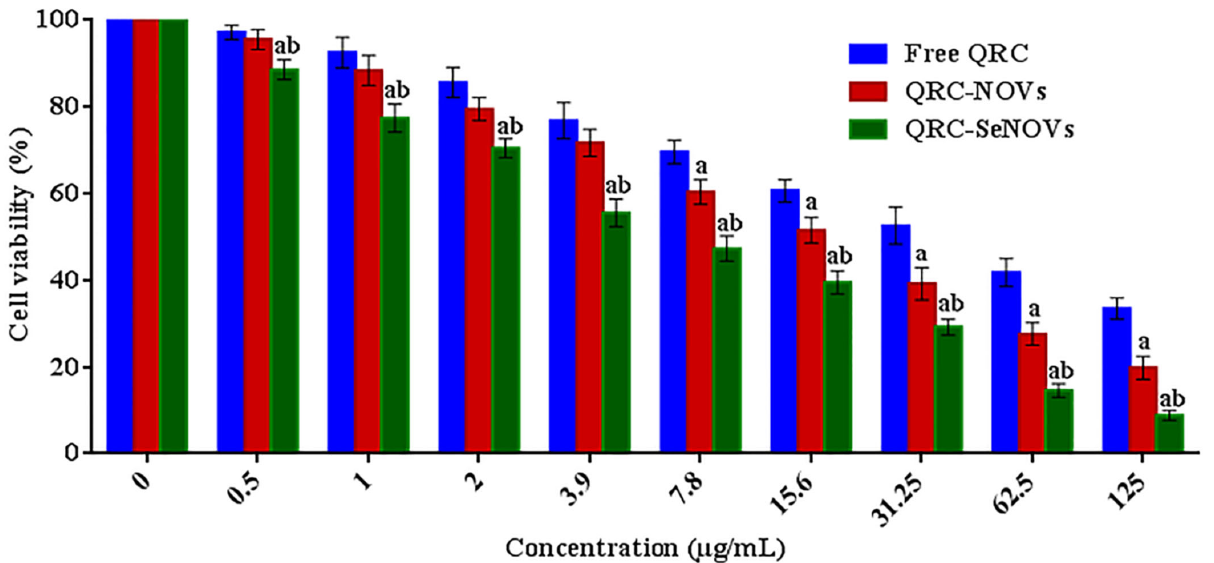
Figure 5. In vitro cytotoxicity of crude QRC, QRC-NOVs, and QRC-SeNOVs against RD cells via MTT assay after 48 h incubation. Data expressed as mean ± SD ( n = 3). a p < 0.05 versus free QRC. b p < 0.05 versus